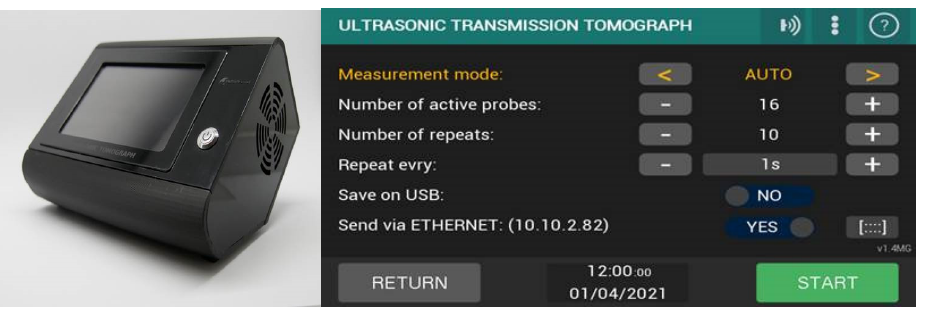
Figure 6. The main module of the UST measurement system and view of the configuration screen.